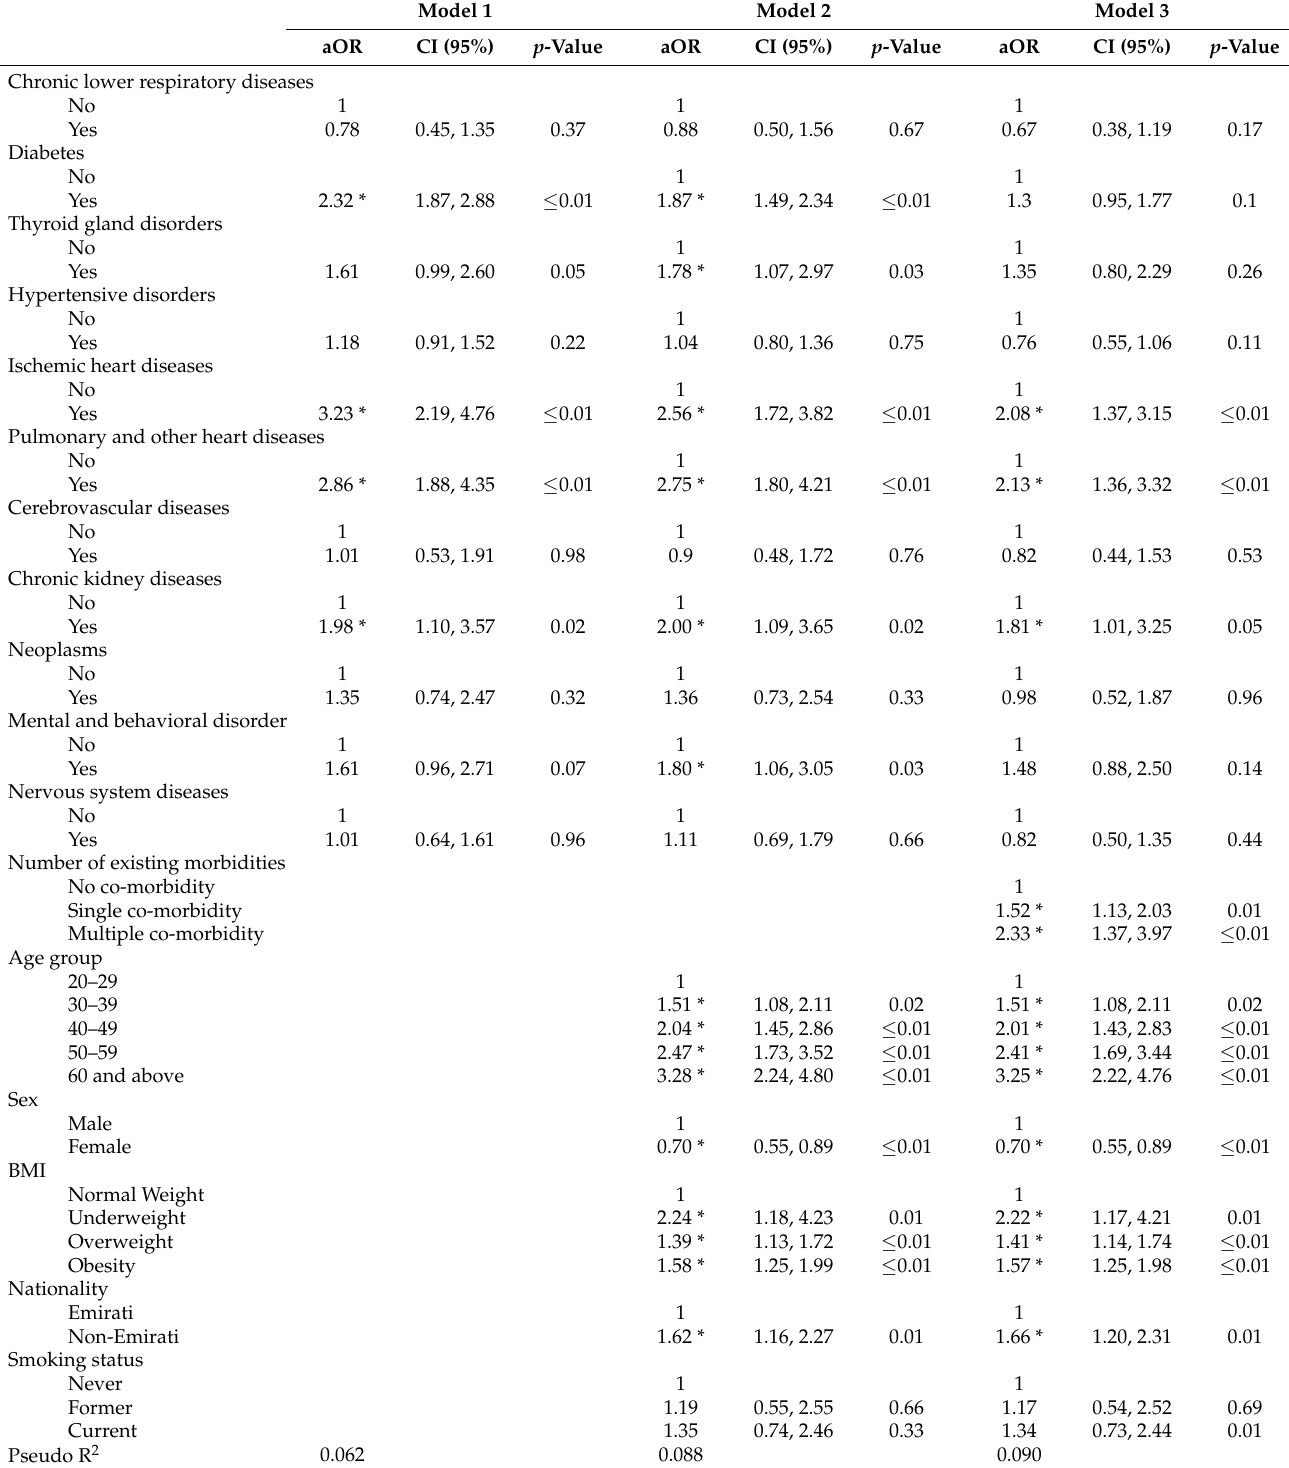
Table 3. Risk factors for COVID-19 severity using multivariable logistic regression, N =